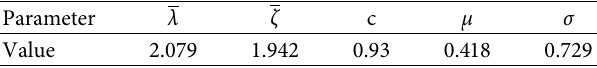
Table 4: Statistical parameters of the phase difference spectrum. Parameter